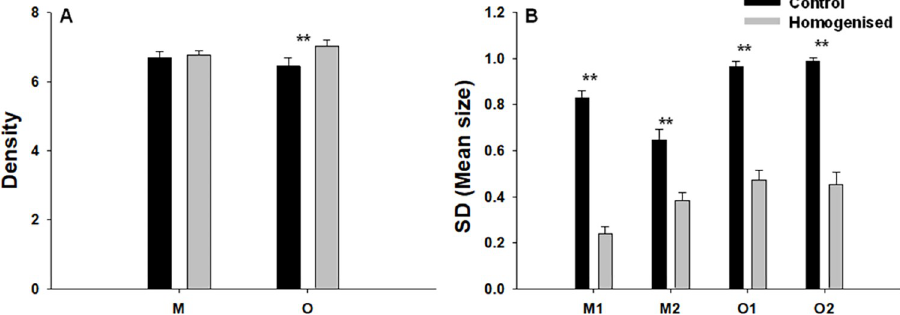
Fig 1. Density of mussels and habitat homogenisation. Mean values (+SE) of density (number of mussels per 10 cm 2 ; Ln(X+1) among locations (sites pooled) (A) and standard deviation of mean size for each site (B) of Mytilus galloprovincialis . Asterisk indicates significant differences (SNK tests, �� : p <